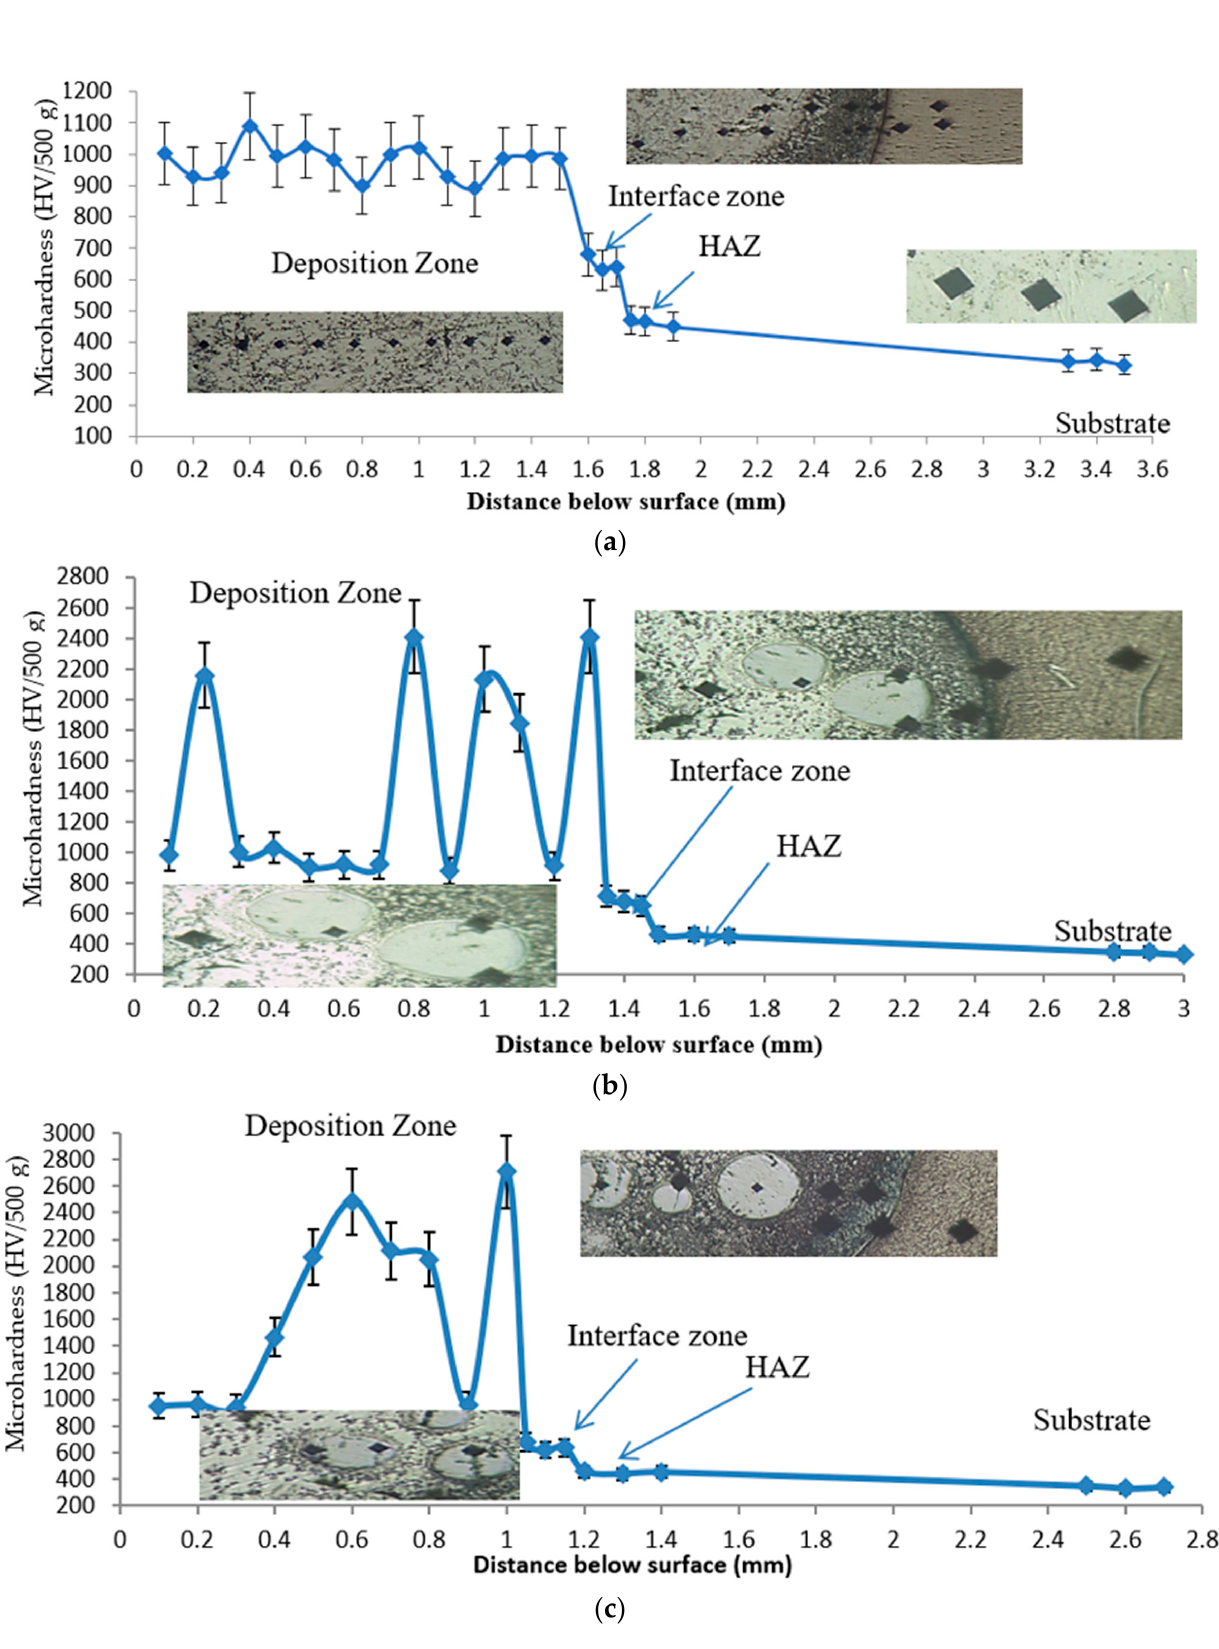
Figure 18. Microhardness profiles along the different zones (DZ, IZ, and HAZ) of the deposited layer of ( a ) sample 1, ( b ) sample 2, and ( c ) sample 3.